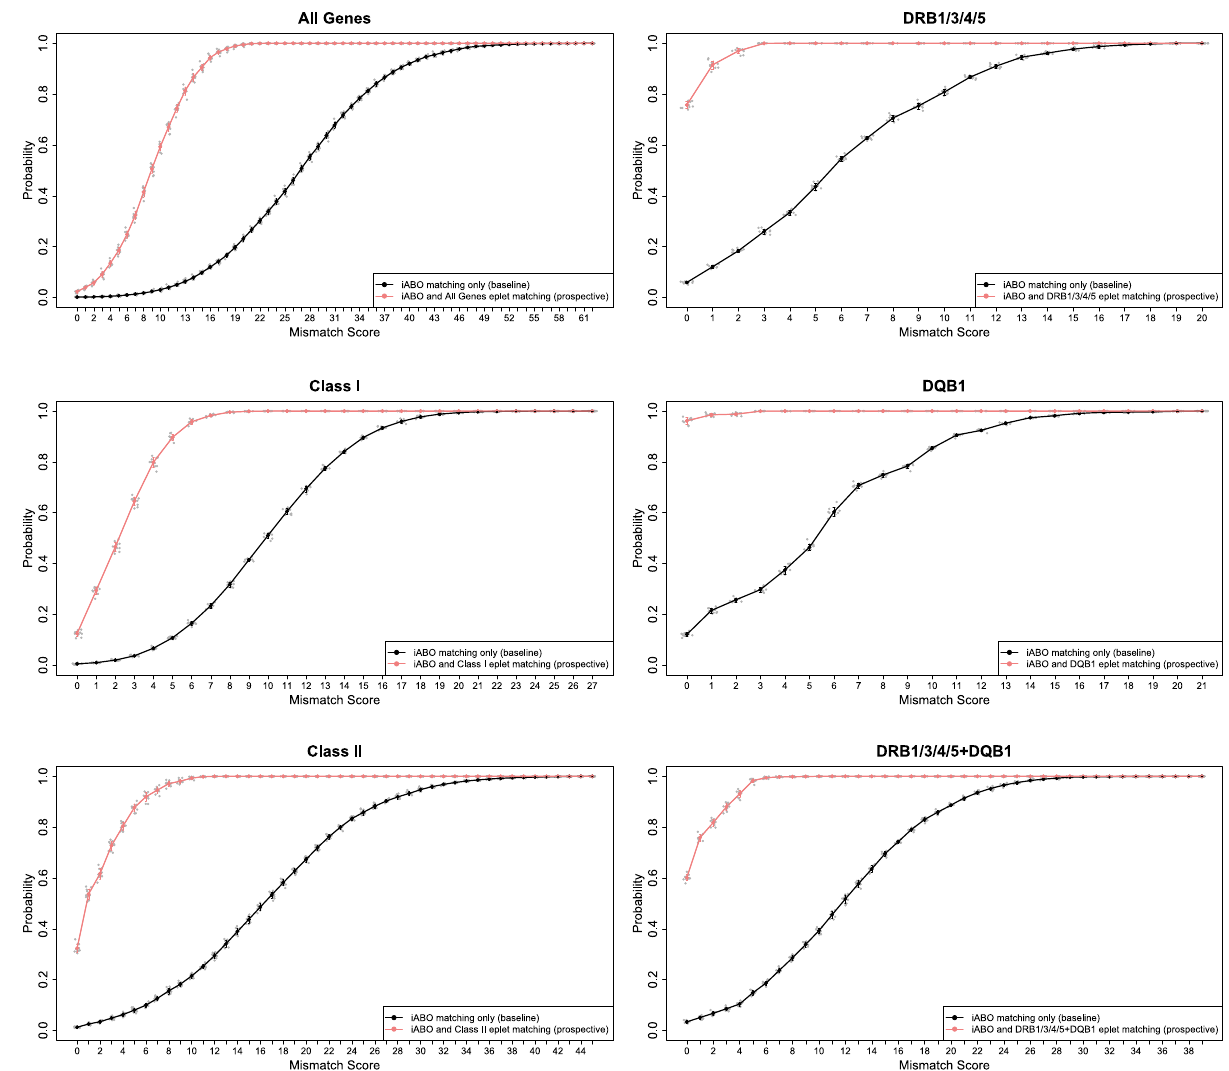
Fig. 8 Cumulative probabilities of eplet mismatches in the national matching simulations with and without prospective eplet matching. Matching simulations incorporated prospective eplet and blood group matching (red curve) and baseline blood group matching only (black curve) in kidney patients and deceased donors. Plots represent simulations using a national Canadian waitlist ( n = 2032 patients) and an annual deceased donor rate ( n = 762 donors) according to Canadian Organ Replacement Register 3 . Simulations were performed across all HLA genes, class I genes, class II genes, DRB1/3/4/5, DQB1, and DRB1/3/4/5 + DQB1 combined. Eplet mismatch scores for the respective genes on the x axis are plotted against the averaged cumulative probability of these scores in the matched population. Jittered grey dots represent the cumulative probabilities at each individual simulation. Error bars are calculated as the standard deviation of ten repeated independent simulation